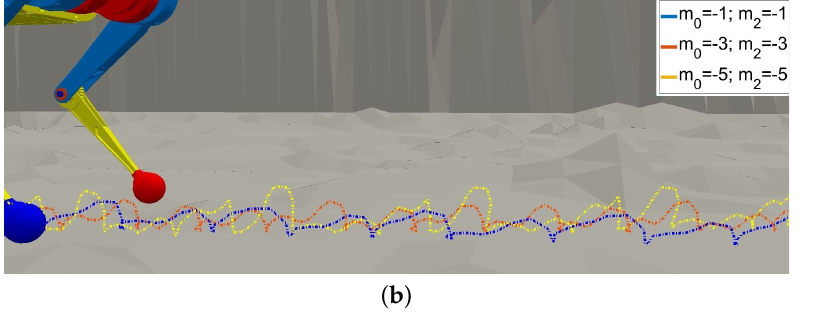
Figure 3. Behaviour of the neuron model and application to the robot locomotion control. ( a ) The FHN limit cycle shapes change based on the m 0 and m 2 parameters; ( b ) traces of the right front leg tip obtained for the selected m .